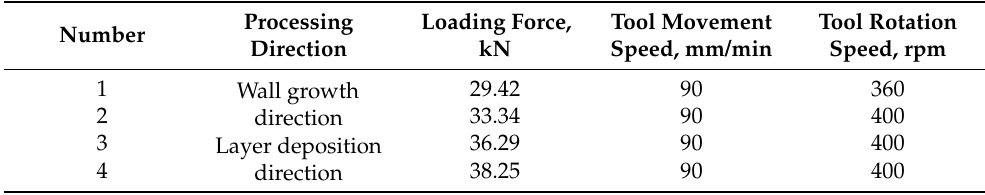
Table 2. Friction stir processing modes.